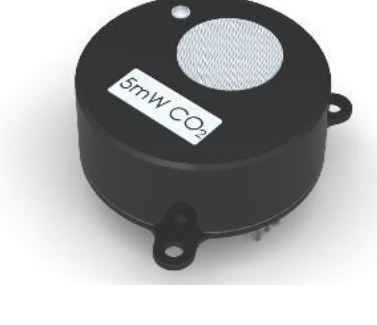
Figure 1. View of the SST Sensing CO2S-A